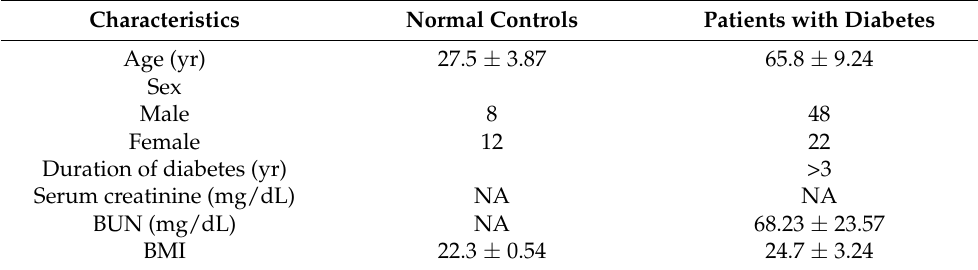
Table 1. Demographic and clinical characteristics of